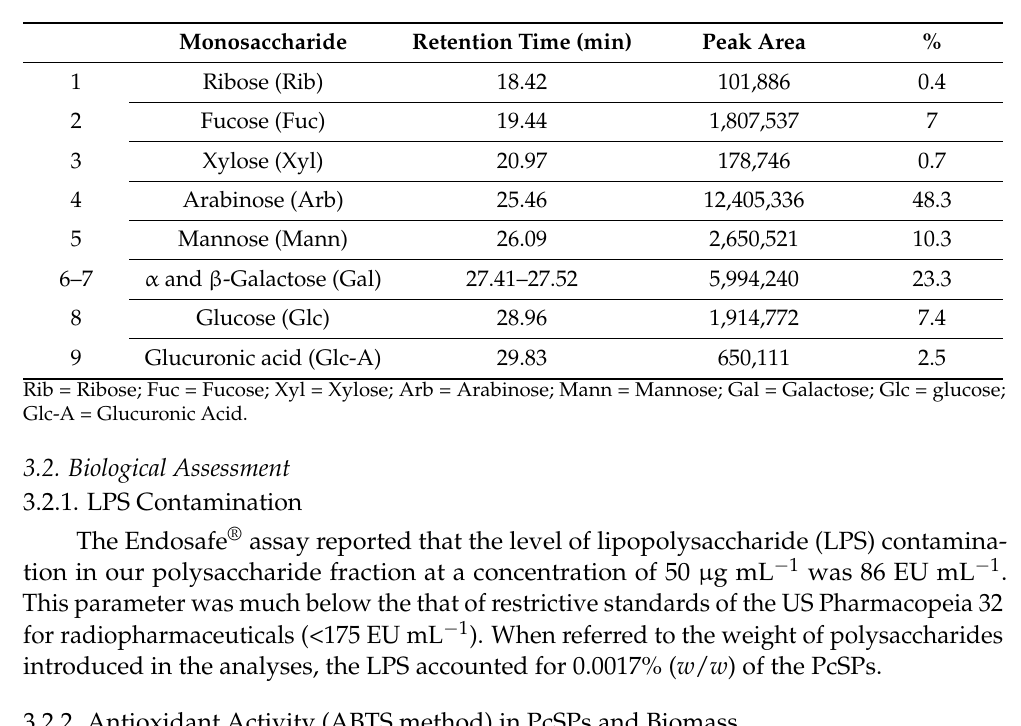
Table 2. Content of monosaccharides in PcSPs.